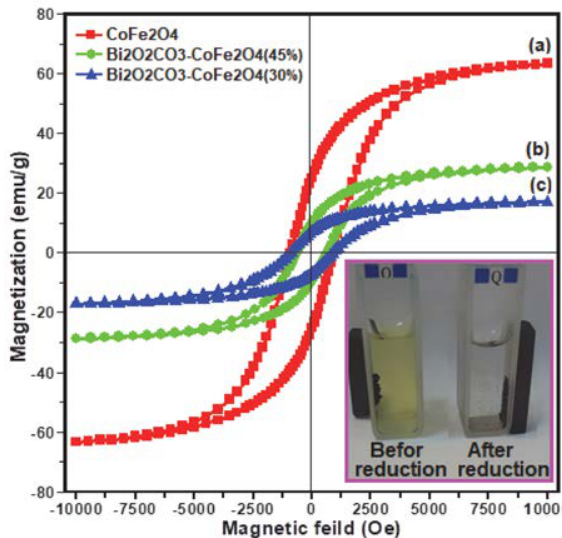
Figure 10. Magnetization curves of (a) pure CoFe 2 O 4 , (b) Bi 2 O- 2 CO 3 /CoFe 2 O 4 45% and (c) Bi 2 O 2 CO 3 /CoFe 2 O 4 30%, The photo in- set shows magnetic separation of the nanocomposite catalyst before and after the reduction of 4-NP by NaBH 4 .